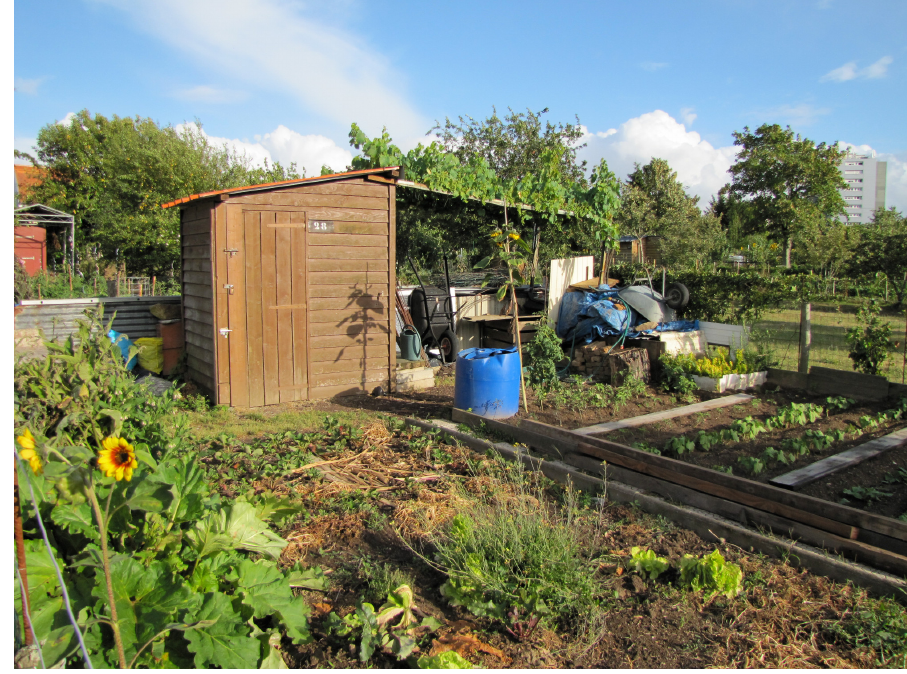
Figure 3. A Shack and a Garden at La Fournilli`ere. Source: